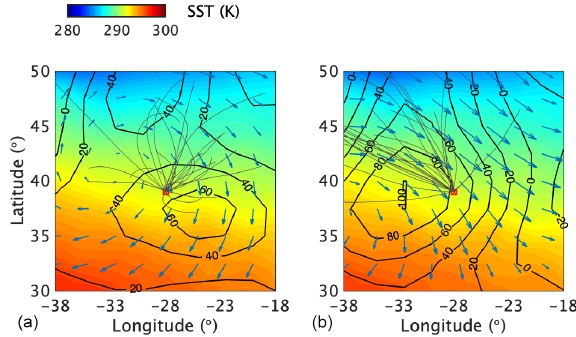
Figure 4. Averaged sea surface temperature (K) (colors), winds (ar- rows) and 700hPa large-scale subsidence (hPad − 1 ) (contours) for closed-cell (a) and open-cell (b) cases from NCEP. The thin gray lines indicate the location of parcels 24h prior to reaching the site. The ARM ENA site is indicated by the red